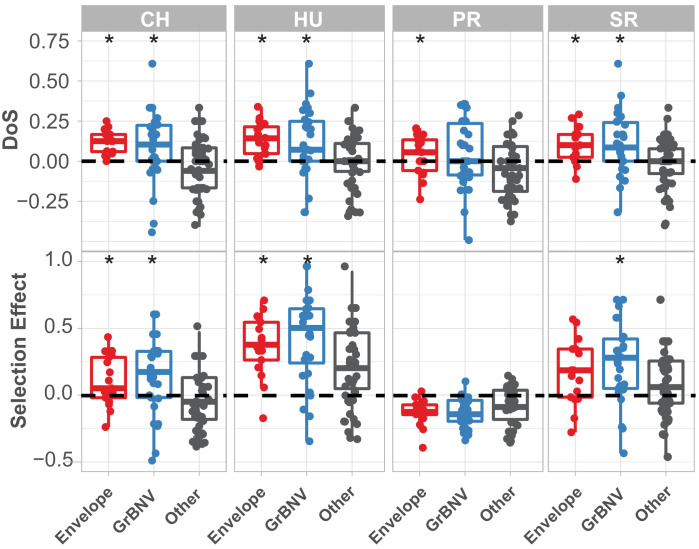
McDonald-Kreitman based statistics for each gene in population of Drosophila innubila Nudivirus, with viral envelope and GrBNV potential virulence factors shown separately.DoS = direction of selection, Selection Effect = SnIPRE estimated weighted DoS. Boxplots marked with a * are significantly higher than background/other viral genes (GLM p-value<0.05). In both cases, values above 0 suggest some proportion of substitutions are fixed by adaptive evolution.